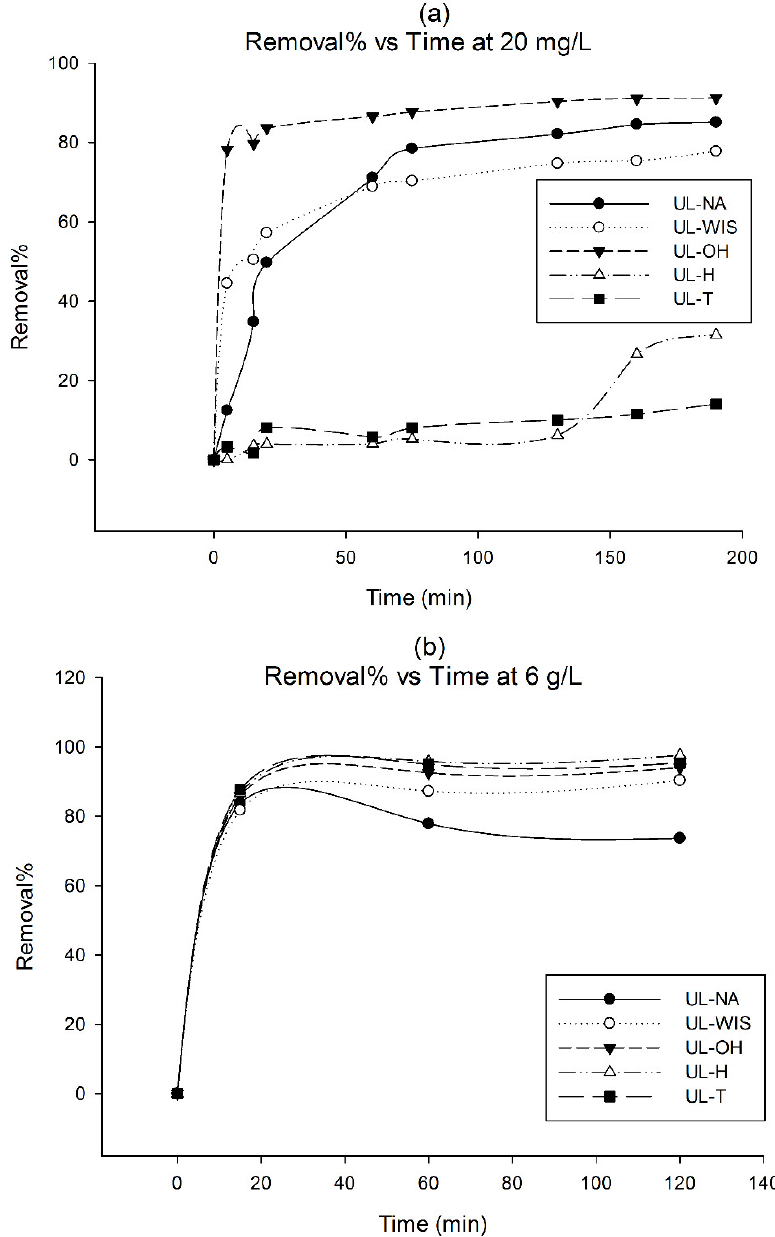
Figure 7. Effect of time on the biosorption of dye with initial concentration of MB = 5 × 10 −5 mol/L, pH = 8; low conc. 20 mg·L −1 ( a ) and high conc. 6 g·L −1 ( b ).